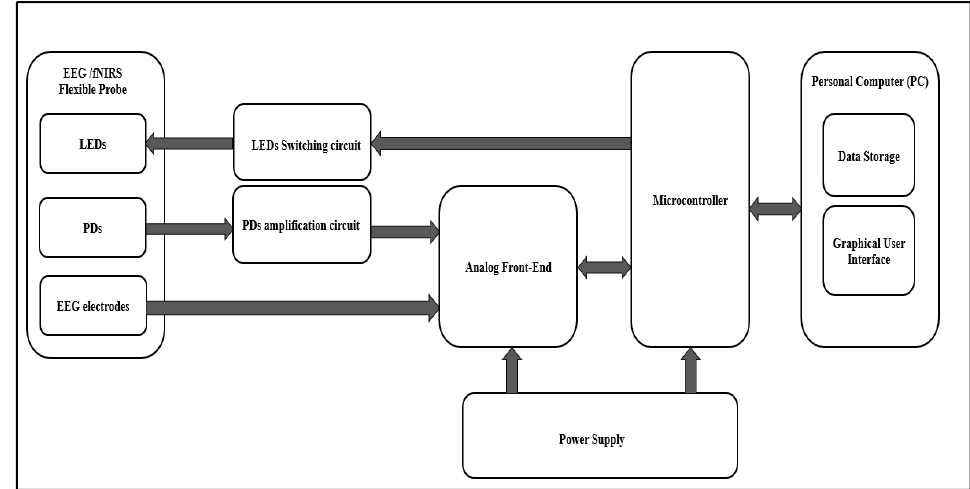
Figure 1. General block diagram of the EEG/fNIRS system. The light emitted from these LEDs passes through the skull in a banana-shape and is then sensed by five OE-PD0064-T PDs (Opto ENG Co., Ltd., Korea). These PDs are high-speed Si PIN PDs that respond to wavelengths ranging from 700 to 1100 nm and have a peak wavelength of about 970 nm and a size of about 4 mm × 5.4 mm. The distance between neighboring PDs, PD1 and LED1, PD3 and LED1, PD3 and LED2, and PD5 and LED2 is 30 mm, and the distance between PD2 and LED1 and PD4 and LED2 is 5 mm, as shown in Figure 2.